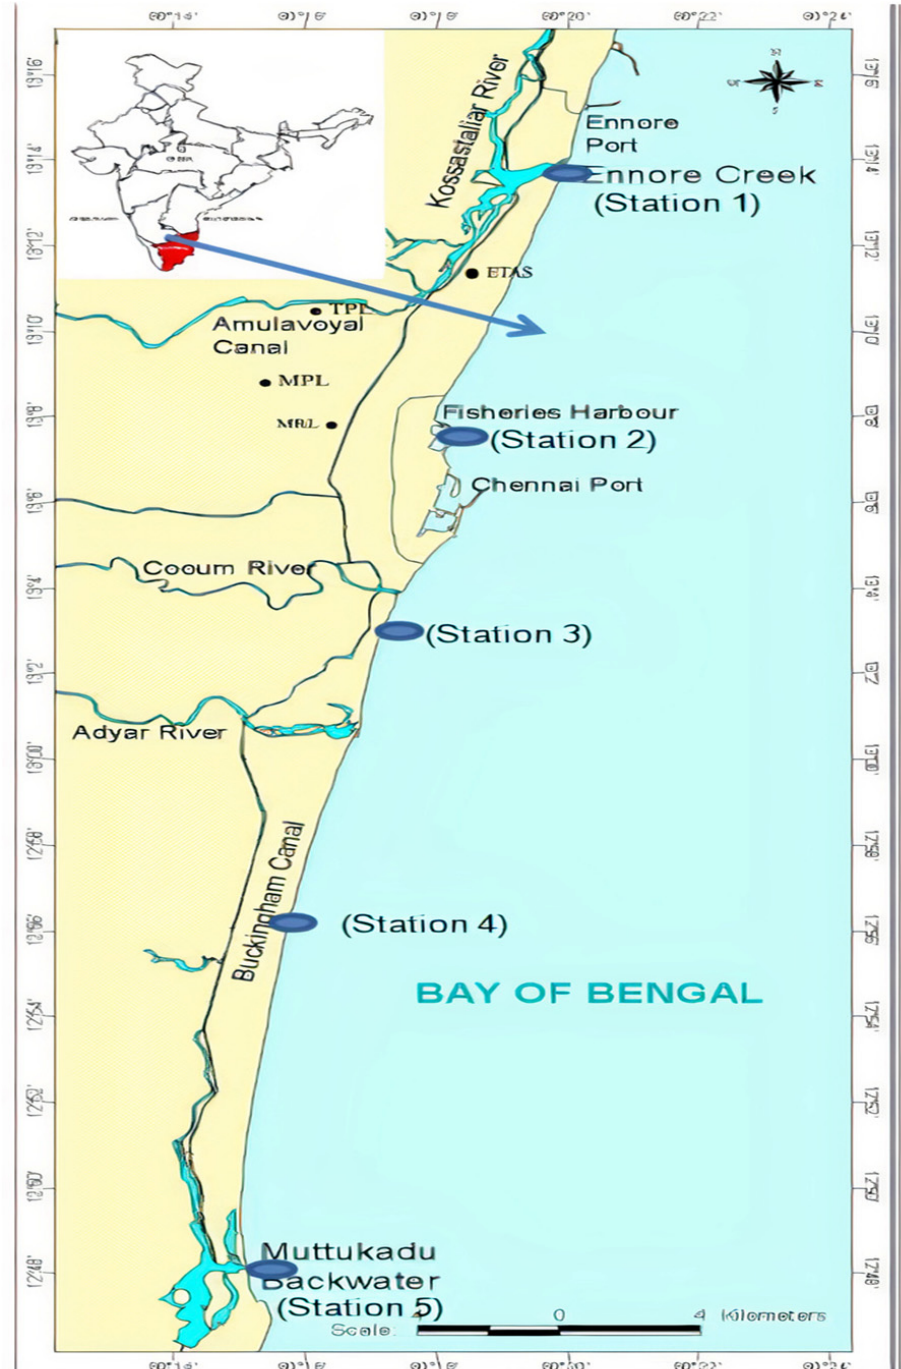
Figure 1. Map showing location of sampling sites along the southeast coast of India.